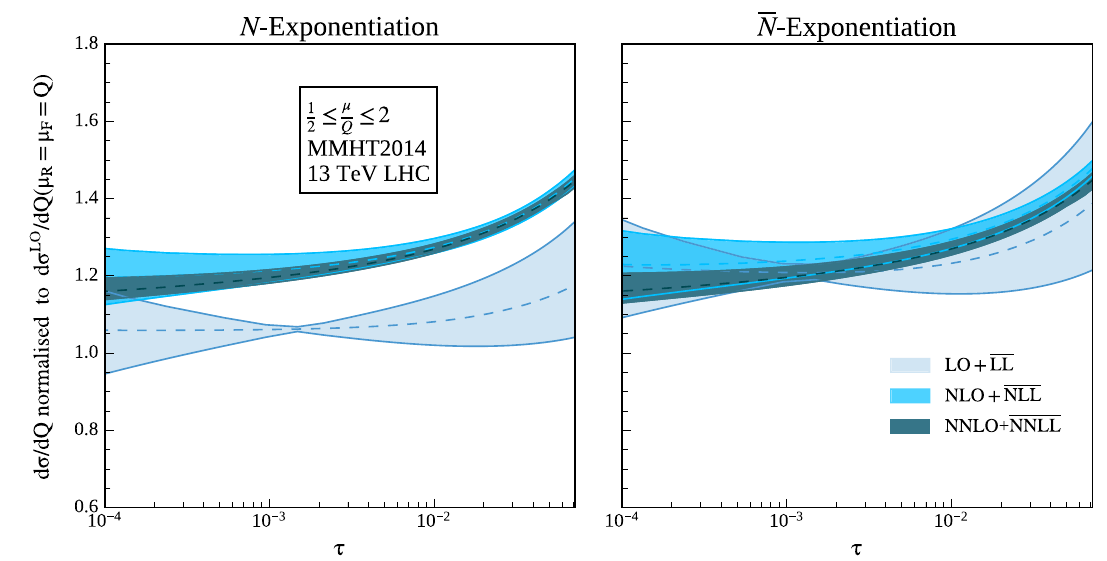
Fig. 15 A comparison between 7-point scale variation in both N and N exponentiation around the central scale choice (μ R ,μ F ) = ( 1 , 1 ) Q for 13 TeV LHC Table 11 A comparison of resummed cross-sections in 10 − 5 pb/GeV between different resummation schemes up to NNLO + NNLL Order Q = μ R = μ F (GeV)